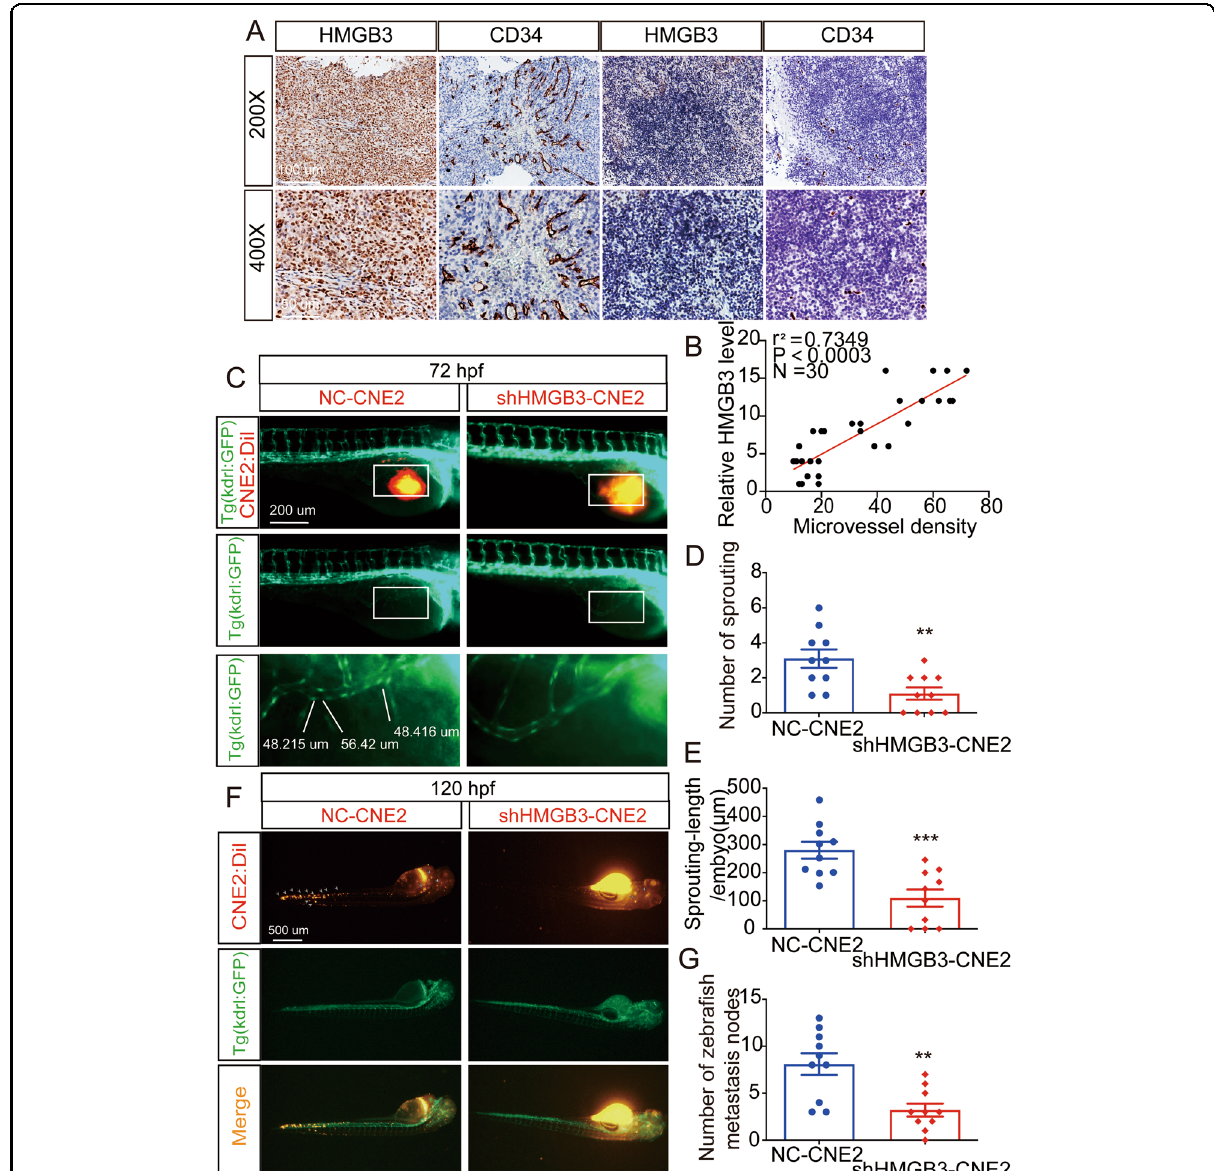
Fig. 5 The positive correlation between HMGB3 and MVD in NPC patients and the further study that CNE2 with HMGB3 knockdown inhibited tumour angiogenesis and metastasis in tg(kdrl:GFP) zebra fi sh embryos. A Representative images of IHC for CD34 and HMGB3 in NPC tissues. The scale bar in 200× images represents 100 µm. B Spearman correlation between HMGB3 score and MVD in NPC patients. Pearson correlation coef fi cient ( r 2 ) and P value are shown. C The overall shape of 96 hpf embryos after injection of about 10 nL of Matrigel/CNE2-NC or Matrigel/CNE2-shHMGB3 solution in the perivitelline space at 48 hpf. White boxes indicate regions of pictures shown in the bottom two pictures and the analysis of the subintestinal venous plexus (SIV) was conducted. The scale bar represents 200 µm. D Quanti fi cations with the number of sprouting of ten embryos per group. E Quanti fi cations with the sprouting-length per embryo of ten embryos per group. F At 120 hpf, the migration of CNE2 cells was measured using fl uorescence microscopy. The scale bar represents 500 µm. G Quanti fi cation of migratory cell numbers of ten embryos per group. Mean ± SD, ** P < 0.01, *** P < 0.001, student ’ s